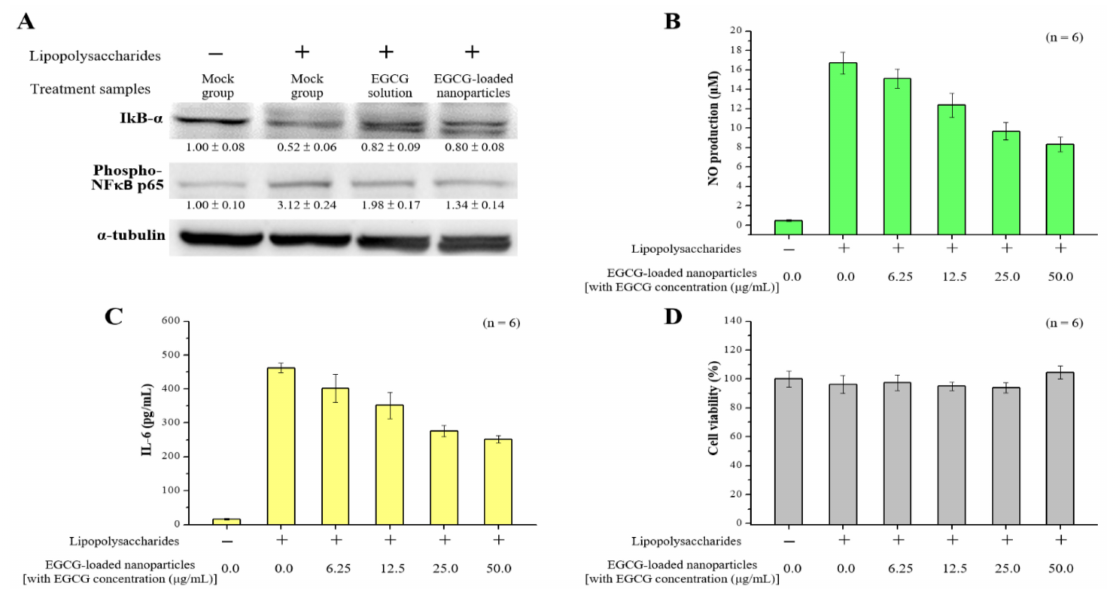
Figure 7. E ff ects of EGCG-loaded nanoparticles on lipopolysaccharide-induced pro-inflammatory mediator productions. ( A ) Western blotting analysis of inflammation-related proteins in macrophage cells after incubation with EGCG solution or EGCG-loaded nanoparticles; ( B ) NO production level; ( C ) interleukin (IL)-6 level; and ( D ) Cell viability as determined at 24 h. Data are presented as means ± SDs ( n =